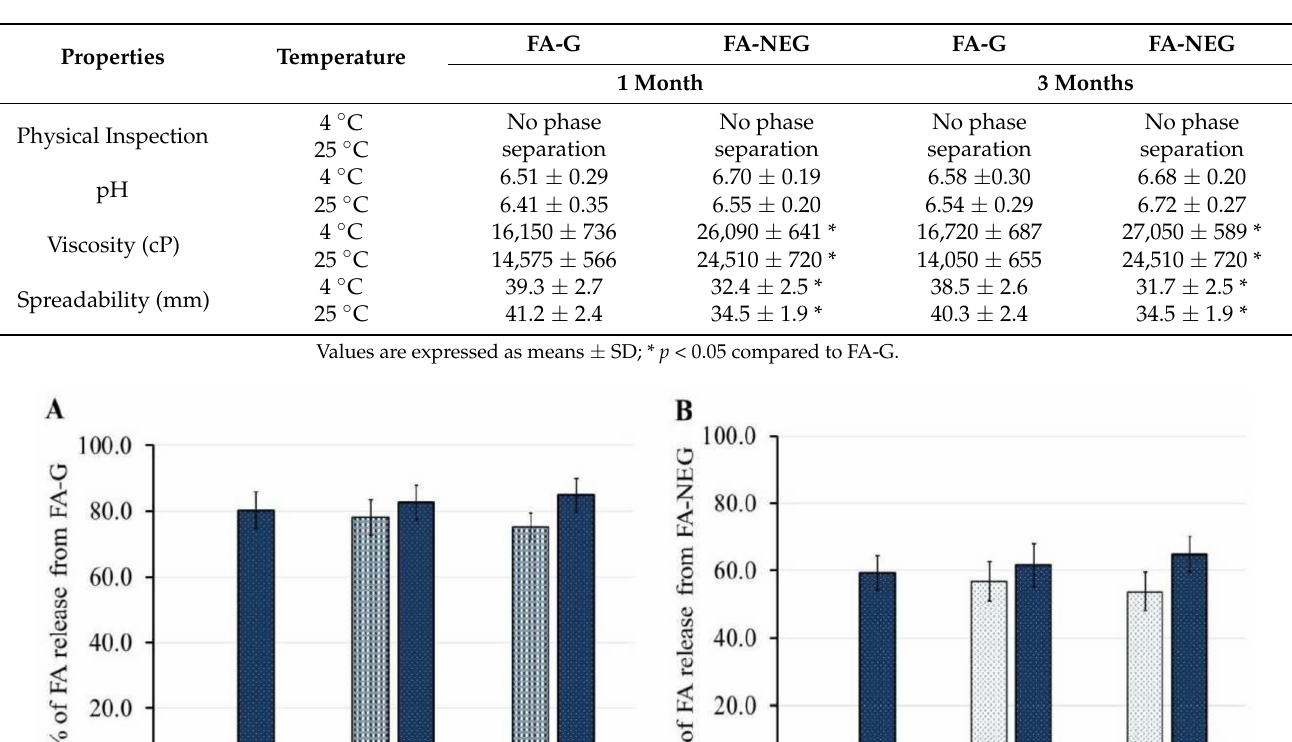
Table 6. Physical characterization of FA-G and FA-NEG after 1 and 3 months of storage at a relative humidity 60% and temperatures of 4 ◦ C and 25 ◦ C.